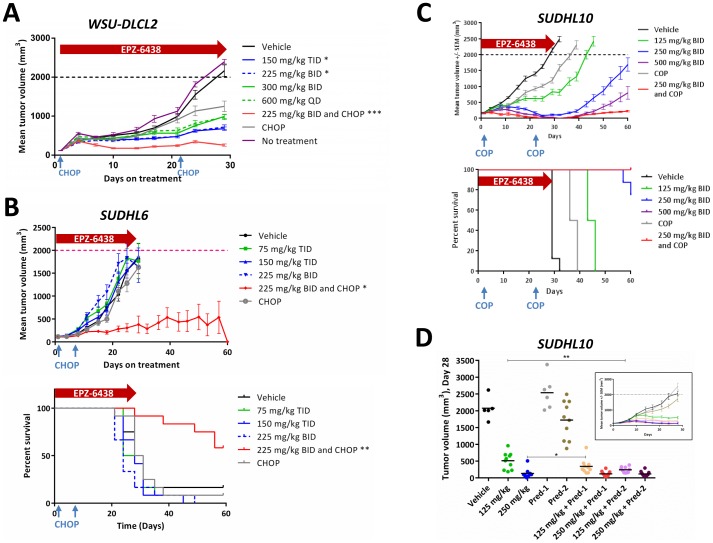
EPZ-6438/CHOP combinations show enhanced anti-tumor activity compared to single agents in several EZH2 mutant lymphoma xenograft models.A) WSU-DLCL2 (EZH2 Y646F) xenograft-bearing mice were treated for 28 days as indicated. Mean tumor volumes ± SEM (n = 12) are plotted. Treatment with EPZ-6438 at 225 mg/kg BID plus CHOP induced the highest tumor growth inhibition (93%). B) SUDHL6 (EZH2 Y646N) xenograft-bearing mice were treated for 28 days as indicated. Mean tumor volumes ± SEM (n = 12) are plotted in the top panel. * p<0.05, *** p<0.001 vs. vehicle, repeated measures ANOVA, Dunnett's post test. Kaplan-Meyer survival curves (bottom panel) out to 60 days demonstrate significant tumor growth delay in animals treated with EPZ-6438+CHOP (** p<0.01). C) SUDHL10 (EZH2 Y646F) xenograft-bearing mice were treated with EPZ-6438, COP (chemotherapy without the Doxorubicin component), or their combination for 28 days. Mean tumor volumes ± SEM (n = 8) are plotted in top panel. Percent survival out to 60 days is plotted in the bottom panel (note: 500 mg/kg and 250 mg/kg+COP survival curves overlap). D) SUDHL10 (EZH2 Y646F) xenograft-bearing mice were treated for 28 days as indicated (Pred-1 = Prednisone at 0.15 mg/kg BID×5 on days 1–5 and 22–26; Pred-2 = Prednisone at 0.15 mg/kg BID×28). The scatter blot shows the tumor volumes on day 28, and the inset shows the mean tumor volumes ±SEM (n = 10) followed over 28 days (also presented in figure S6B). * p<0.05, ** p<0.01; two-tailed t test. All groups administered EPZ-6438 show statistically significant smaller tumor volumes on day 28 (p<0.01 at least, vs. vehicle or Prednisone single agent at both schedules; two-tailed t test). CHOP: Cyclophosphamide, Hydroxyldaunorubicin (Doxorubine), Oncovin (Vincristine), Prednisone; COP: Cyclophosphamide, Oncovin (Vincristine), Prednisone; BID: two times a day every 12 hours; QD: once a day; TID: three times a day every 8 hours.